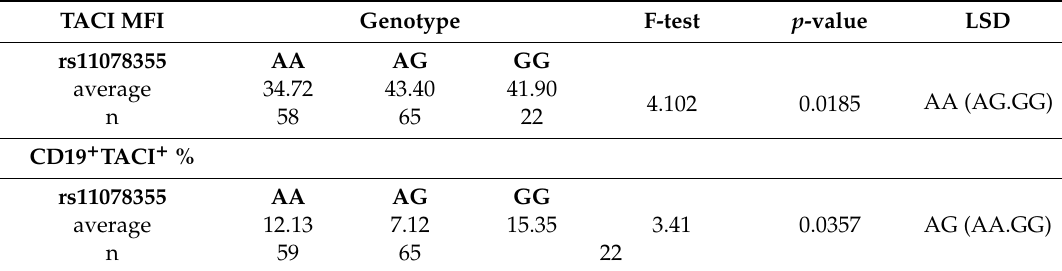
Table 2. Average values of TACI mean fluorescence intensity (MFI) and % of TACI + leukemic cells according to rs11078355 genotypes. TACI MFI Genotype